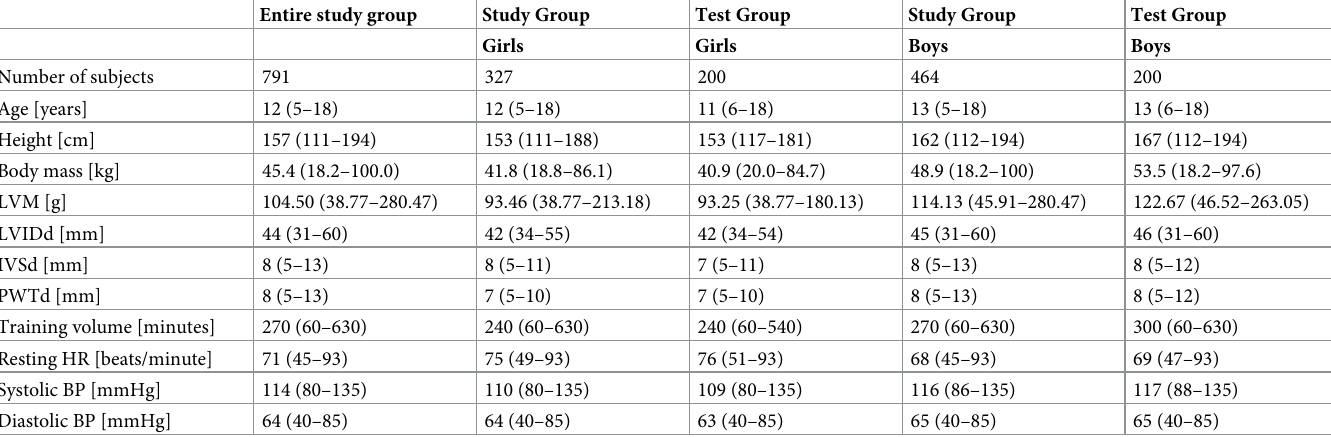
Table 1. Characteristics of the entire study group, the sex-specific study groups, and test groups.